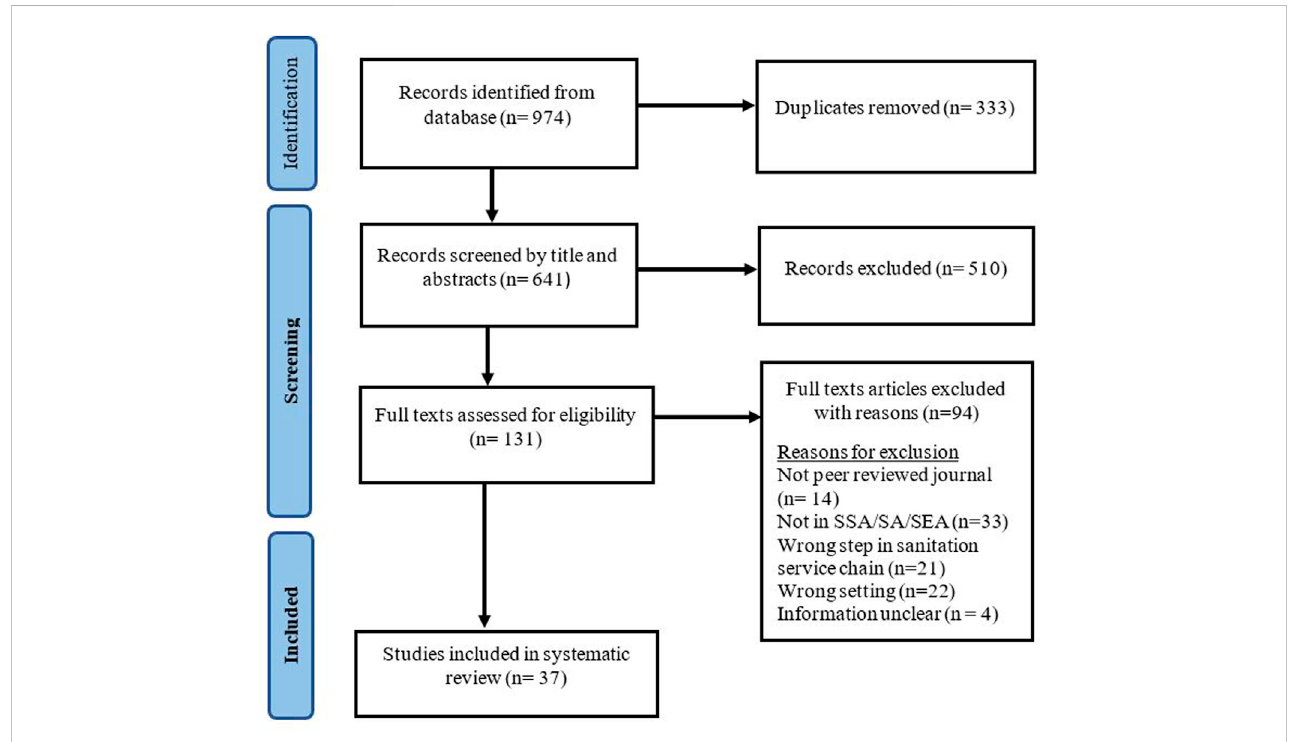
FIGURE 1 PRISMA fl ow diagram for studies in the systematic review of faecal sludge emptying in sub-Saharan Africa, South and Southeast Asia.